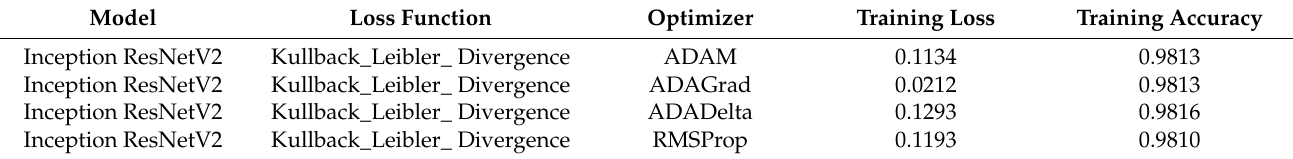
Table 3. Validation results of various models with a learning rate of 0.0001 and a batch size of 32, with model names and loss Figure 7. Output obtained using RMSProp optimizer: ( a ) loss function; ( b ) accuracy; ( c ) sensitivity.